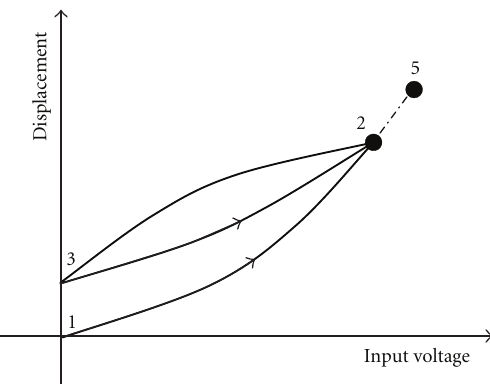
Figure 4: Hysteresis curve movement